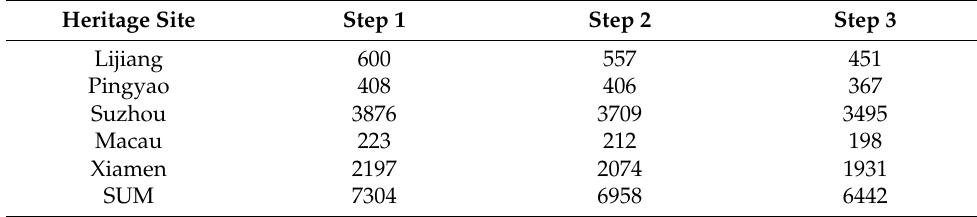
Table 5. The process and result of screening obtained